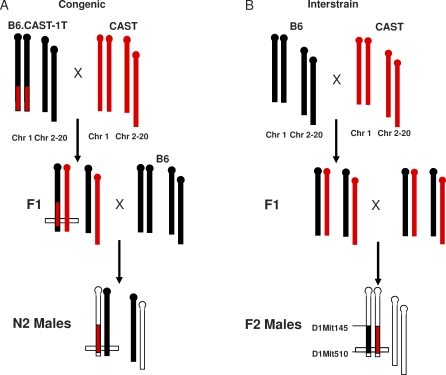
Crosses for Mapping of Trans-Acting Genes(B6.CAST-1TxCAST)xB6 (A) and B6xCAST (B) crosses used for mapping trans-acting genes. B6 sequences are in black, and CAST in red. The region where the recombination is studied is boxed. Segregating loci are located in the white regions. Note that any recombination within the congenic region between the B6.CAST-1T and CAST chromosomes does not alter the allelic composition of this region.